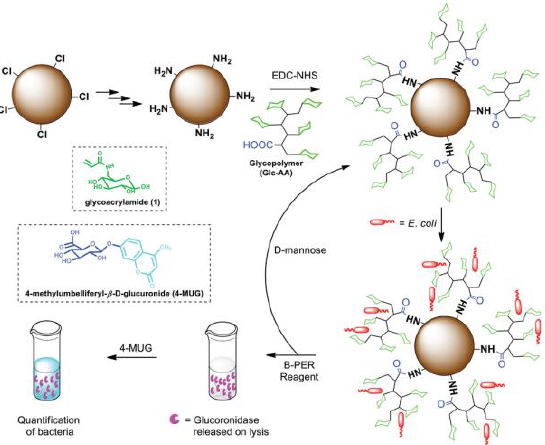
Figure 3. Schematic diagram of the synthesis of a glycopolymer − functionalized resin (Resin − Glc) for capture and quantification of Escherichia coli /ConA. Figure reproduced from ref. [26] with permission.